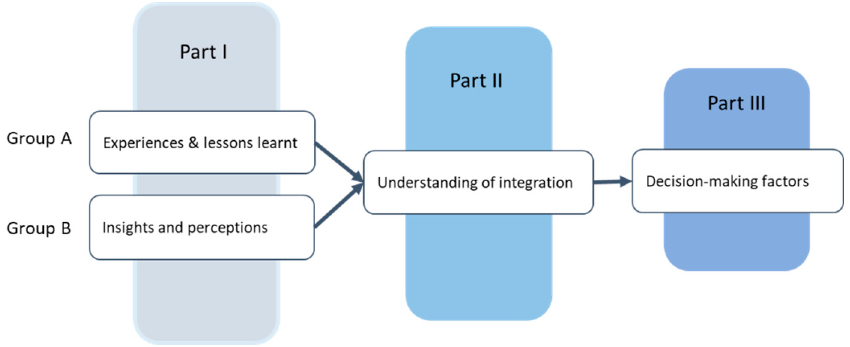
Figure 2. Stages in the questionnaires.